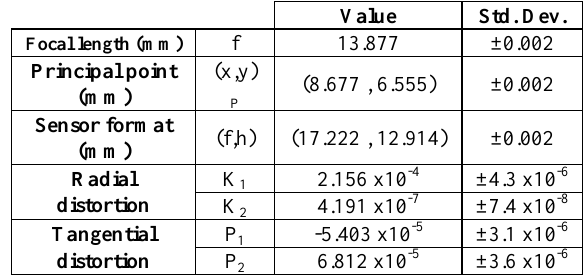
Table 2. Olympus E-P1: technical specifications.